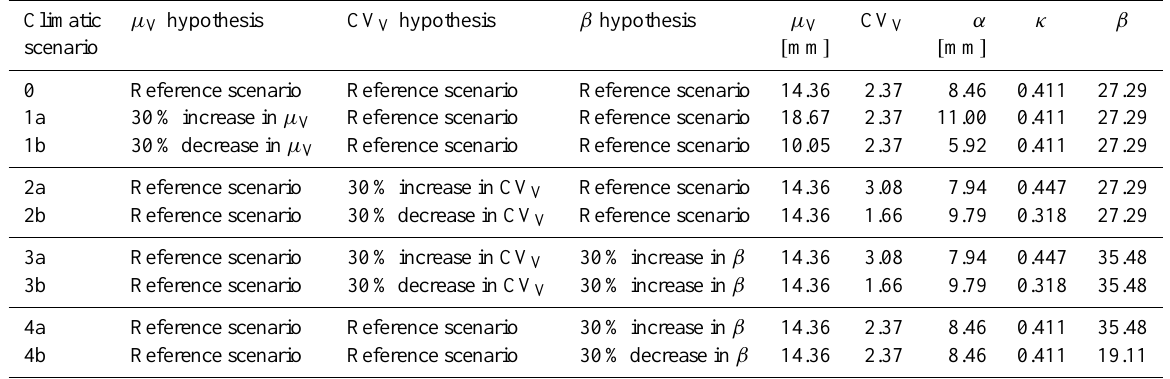
Figure 2. Annual maximum flood quantile variations for scenarios 1.a ( + 30% µ V ) and 1.b ( − 30% µ V ) and for S/µ V = 3.5, 5 and 10. Table 1. Climate scenarios considered for significance